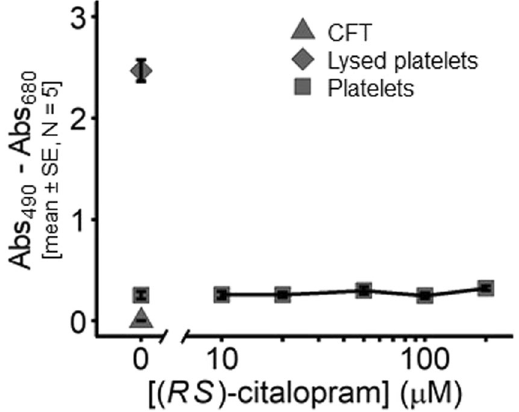
Figure 7. Micromolar concentrations of citalopram do not cause cytotoxicity, as indicated by LDH release from platelets. Platelets were incubated for 10 min with ( RS )-citalopram (0–200 µ M). Calcium-free Tyrodes (CFT) and lysed platelets were used as negative and positive controls, respectively (N = 5 blood donors).